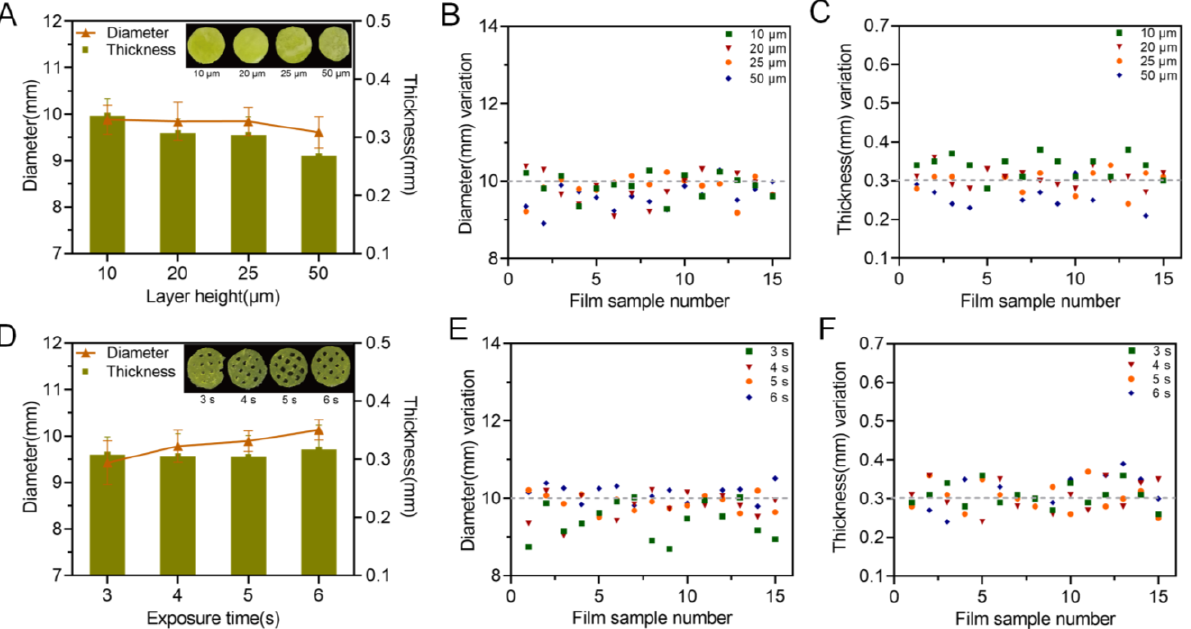
Figure 8. Influence of printing parameters on the printability of the oral films. Exposure time and layer height; ( A ) effect of layer height on the diameter and thickness of 3D-printed oral films (n = 15); ( B ) diameter variations and ( C ) thickness variations of 3D-printed oral film samples from ( A ); ( D ) effect of exposure time on the diameter and thickness of 3D-printed oral films (n = 15); ( E ) diameter variations and ( F ) thickness variations of 3D-printed oral film samples from ( D ).